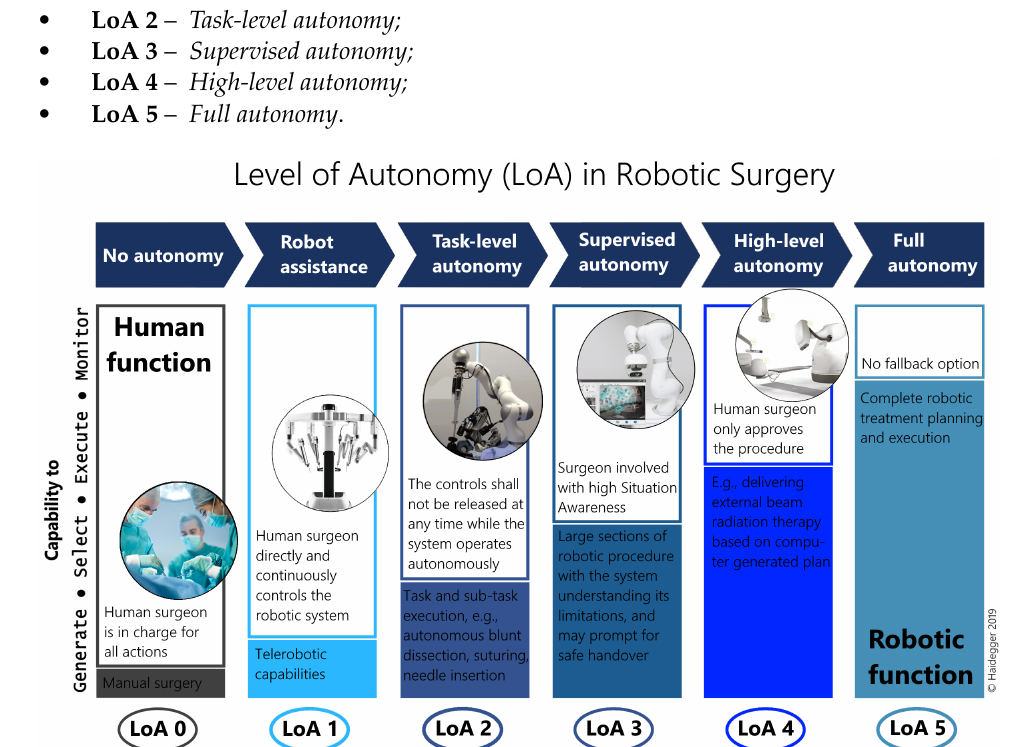
Figure 4. The Level of Autonomy (LoA) concept for Robot-Assisted Minimally Invasive Surgery (RAMIS) proposed by Haidegger [10] with a scale 0–5; from no autonomy to full